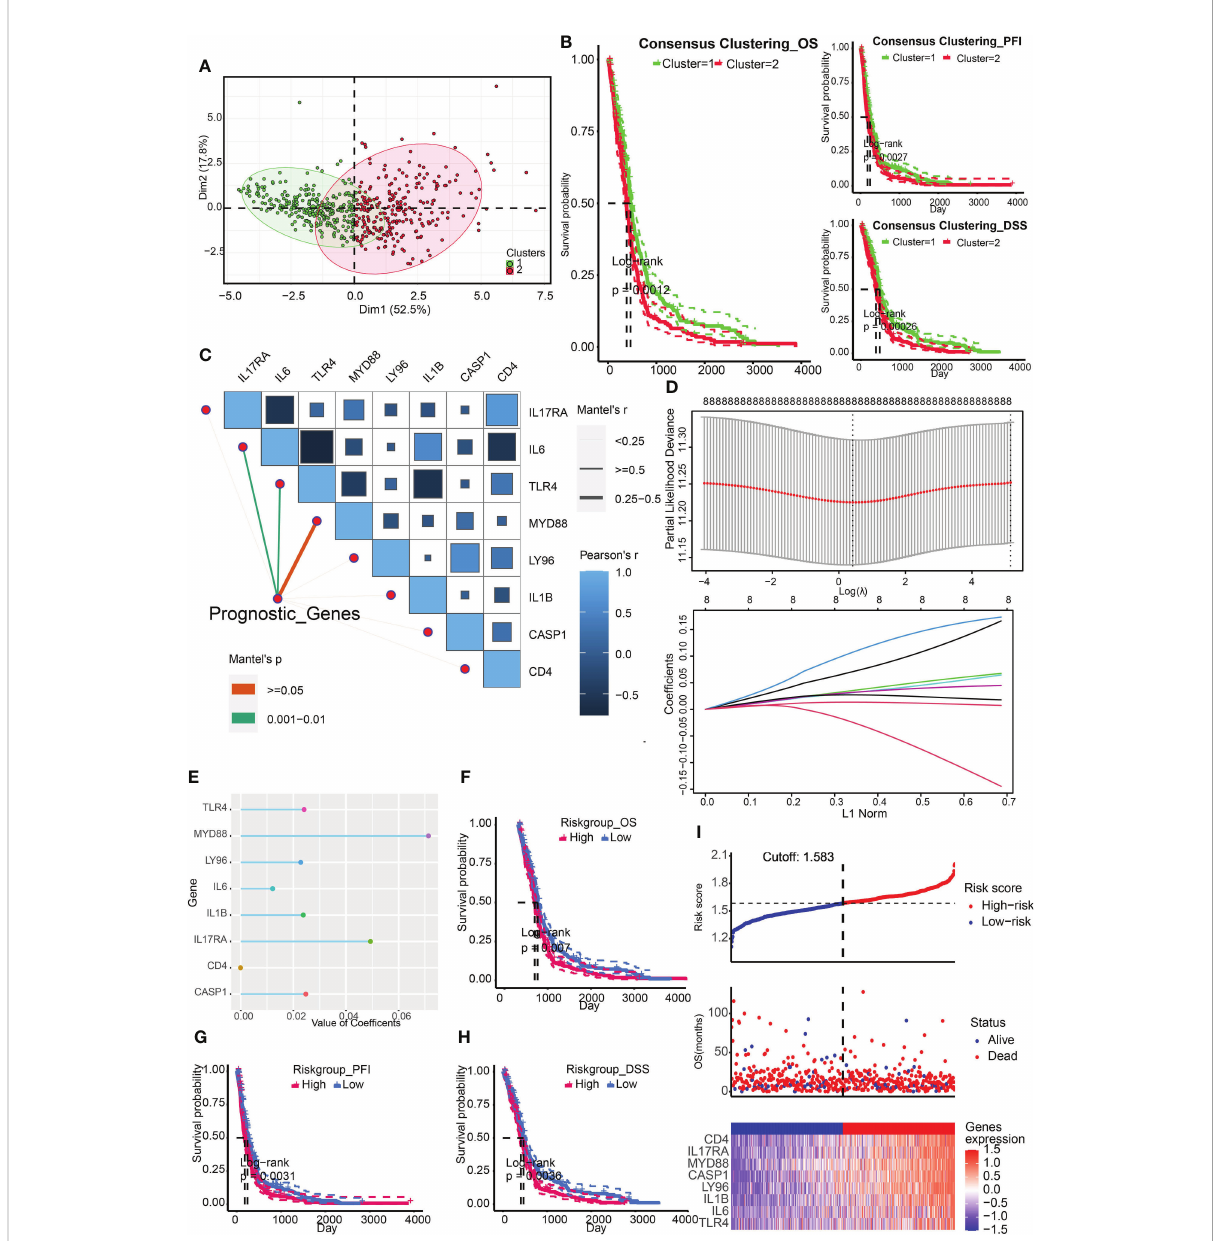
FIGURE 1 Construction of ICD related clusters and risk signature. (A) Two ICD related clusters were obtained from the TCGA Array dataset by applying consensus clustering. (B) Survival analysis indicated that cluster 2 was associated with a dismal prognosis from the perspective of OS, PFI, and DSS. (C) Univariate regression analysis identi fi ed 8 signi fi cant prognostic ICD genes including IL17RA, IL6, TLR4, MYD88, LY96, IL1B, CASP1, and CD4. (D) The eight genes were tested for the prediction model by ridge regression. (E) The correlation coef fi cients of the eight genes were displayed. (F-H) Survival analysis indicated that a higher risk score was correlated to worse OS (F) , PFI (G) , and DSS (H) . (I) Risk scores distribution, patient survival status, and gene expression heatmap were displayed. P < 0.05, statistically signi fi